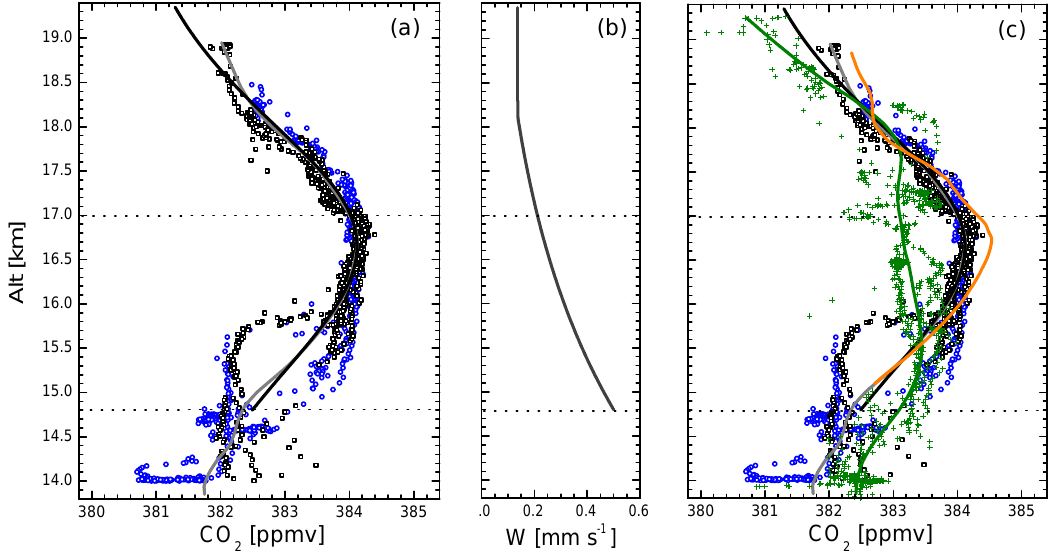
Fig. 3. (a) Vertical profiles of CO 2 obtained on 5 and 6 August . All values are same as shown in Fig. 1, but are plotted against altitude. The gray line denotes the smoothed CO 2 profiles. The black solid line corresponds to the best fit to the observations with the optimum w(z) and K . The lack of compactness found in the altitude profile between 14.7km and 16km unlike the θ –space profile in Fig. 1 is due to vertical, reversible fluctuation of air particles. (b) Vertical profile of ascent rate, w(z) derived from the 1-D advection-diffusion model. (c) Observations between 25 ◦ N and 35 ◦ N for two transit flights on 3 and 9 August are plotted with green cross symbols. When assuming that the observed profile in Fig. 3a is a result of dilution by horizontal mixing along the isentropic levels and 30% of air mass in the profile is originated from the extratropics, the hypothetical CO 2 profile before the dilution is given in the orange line. Note the maximum of the profile corresponds to the seasonal peak (384.5ppmv CO 2 ) of the modified CO 2 index that occurred in May